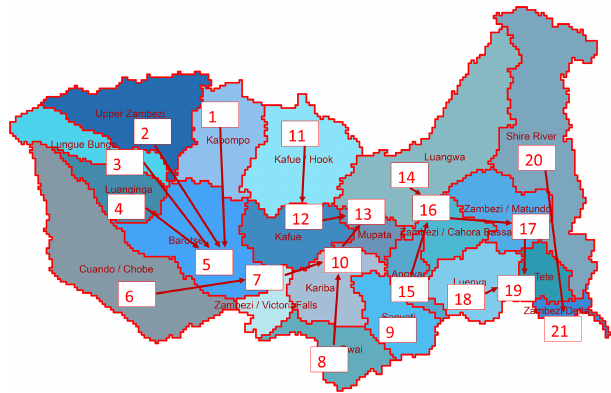
Figure 12. Subbasins of the Zambezi basin for aggregating data from CWatM.